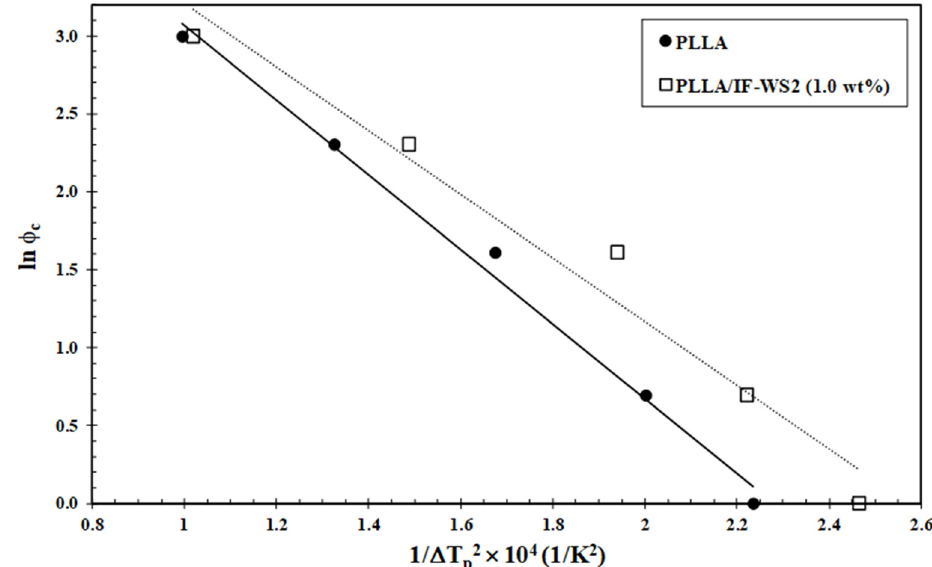
Figure 7. Dobreva plots for evaluating nucleation activity of IF-WS 2 in PLLA/IF-WS 2 (1.0 wt%) nano- composites.